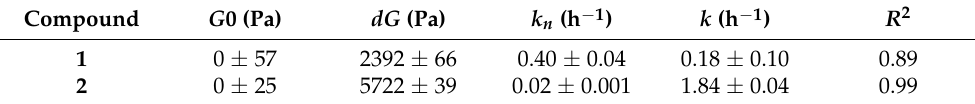
Table 2. Parameters from the Sait ô ’s equation computed from separate fits to the kinetics. Compound